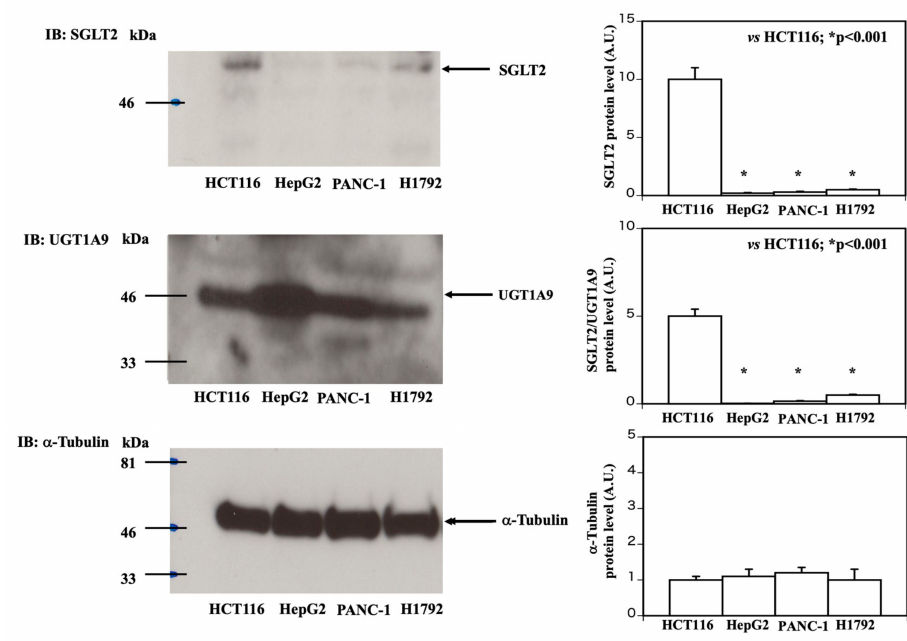
Figure 2. Comparison of SGLT2 and UGT1A9 protein levels in HCT116, HepG2, PANC-1, and H1792 cells. HCT116, HepG2, PANC-1, and H1792 cell extracts were prepared and immunoblotted for SGLT2 (upper panel on left side), UGT1A9 (middle panel on left side), and alpha-tubulin (as loading control; lower panel on left side). The quantification of the SGLT2 protein levels (upper panel on the right side, n = 3, HCT116 vs. HepG2 or PANC-1 or H1792, * p < 0.001), SGLT2 protein levels against UGT1A9 protein levels (middle panel on the right side, n = 3, HCT116 vs. HepG2 or PANC-1 or H1792, * p < 0.001), and alpha-tubulin protein levels (lower panel on the right side, not significant among four cells) is shown as a bar